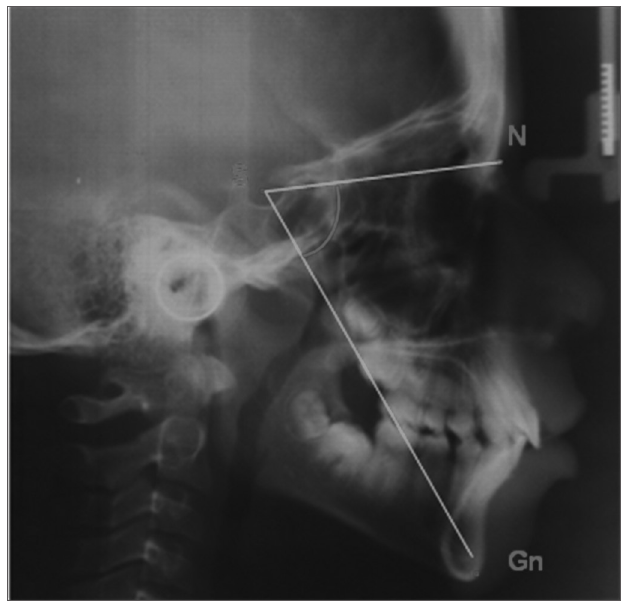
Figura 1. SN.Gn - Ângulo formado entre os pontos Sela, Nasio e Gnatio.